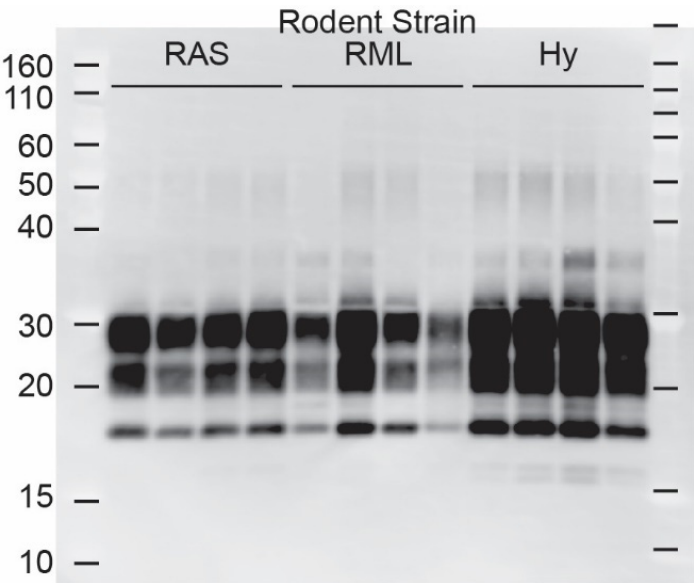
Figure 2. TgBeaver-adapted rodent prions. TgBeaver mice were inoculated with rodent-adapted scrapie from rats (RAS), or mice (RML) or hamster-adapted transmissible mink encephalopathy (Hy). 1 The 0% brain homogenates were digested with 50 µ g/mL of PK and analyzed by Western blotting. The monoclonal antibody Bar224 was used to detect beaver PrP-res at a dilution of 1:10,000.